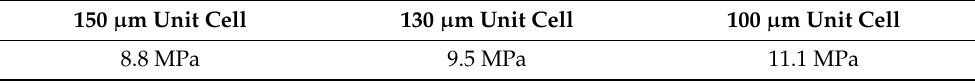
Figure 7. Loading-unloading traces of the micro-lattice structures with unit cell length L of ( a ) 150 µ m; ( b ) 130 µ m; ( c ) 100 µ m. Table 4. Compressive stiffness of lattice structures with different unit cell